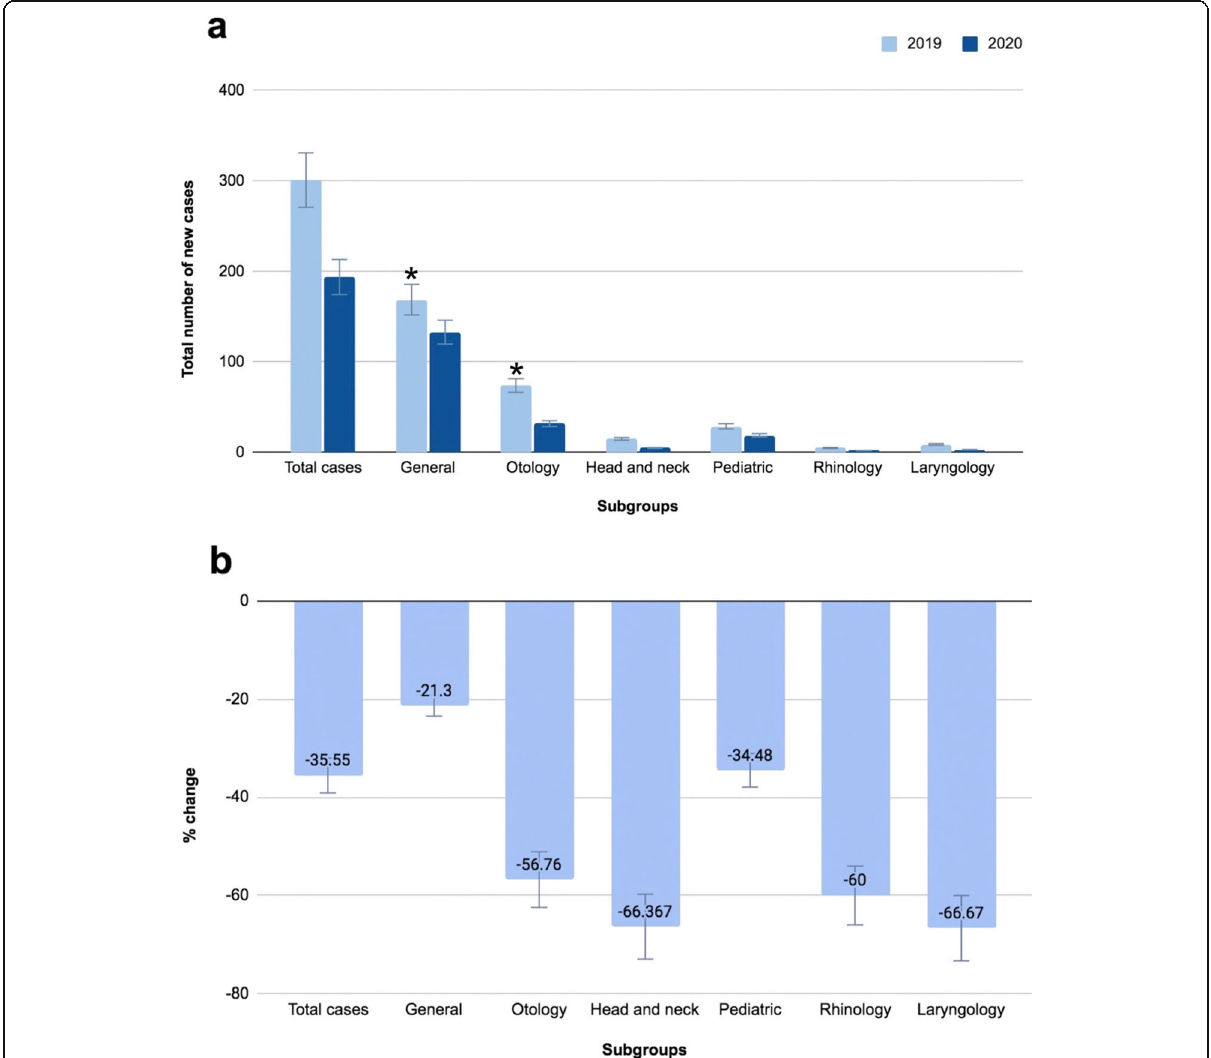
Fig. 2 Comparison of outpatient visits between 2019 and 2020 in each Otolaryngology subgroup: a number of new outpatient visits in each Otolaryngology subgroup; b changes in the percentage of new visits * p < 0.05 (chi-square